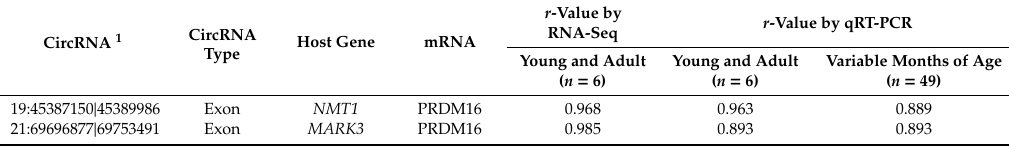
Table 3. Two circRNA–mRNA pairs with potential e ff ects on fat deposition. CircRNA